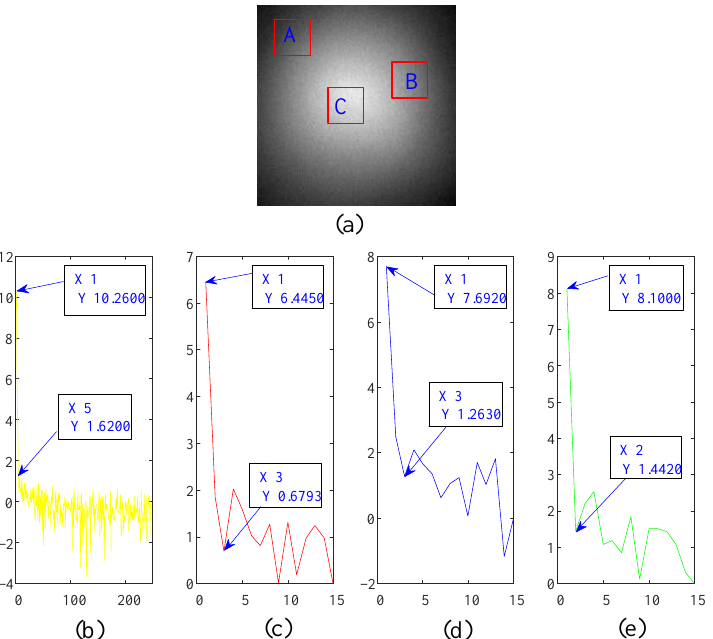
Figure 3. The global and local low-rank analysis of random non-uniform strong vignetting image. ( a ) Original video frame image. A, B, and C are three randomly selected local regions, and their scale is 15 × 15. ( b ) The singular value gradient logarithmic curve of the whole image. ( c – e ) are the singular value gradient logarithmic curves of the regions A, B, and C, respectively. Table 1. The data of the sparse factors and their corresponding regional scale.